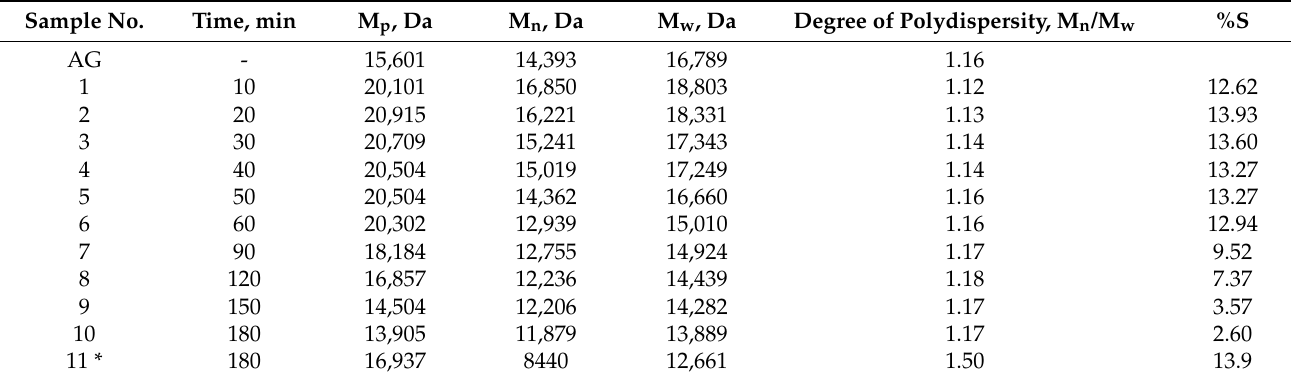
Table 6. MWD for the samples of the reaction mass sulfated at a temperature of 95 ◦ C, the ratio of the amount of the complex to the amount of the polysaccharide corresponds to 1:15. Sample